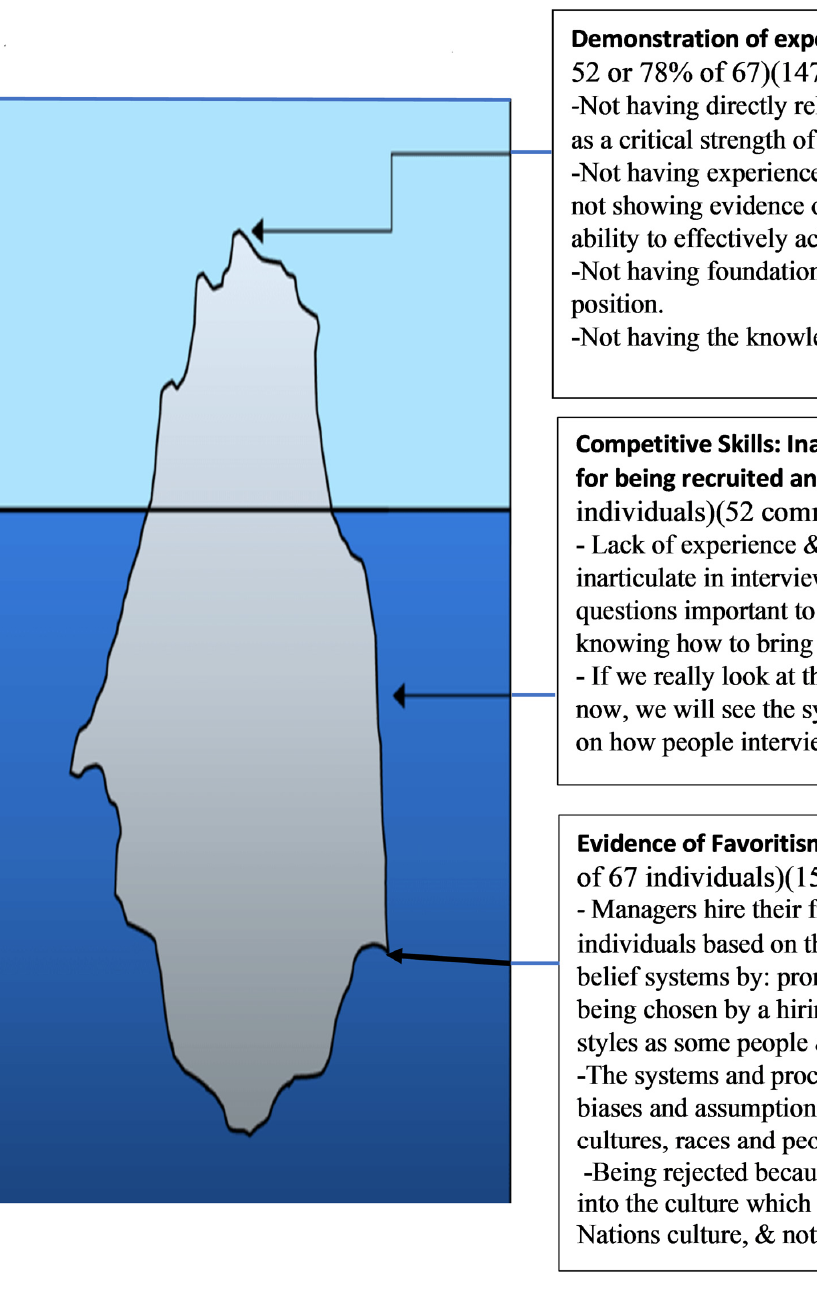
Figure 1. An iceberg view of the visible and lee visible causes of career